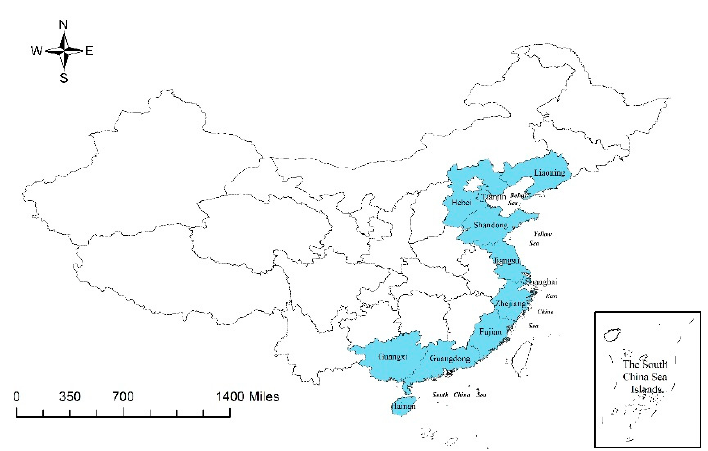
Figure 1. Regional map of 11 provinces and cities along the east coast of China.